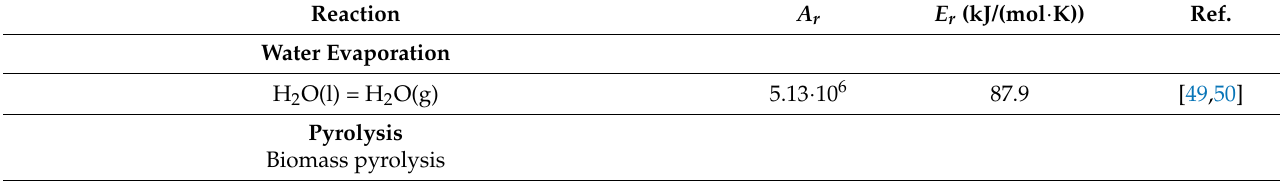
Table 5. Kinetic parameters of chemical reactions of CLF